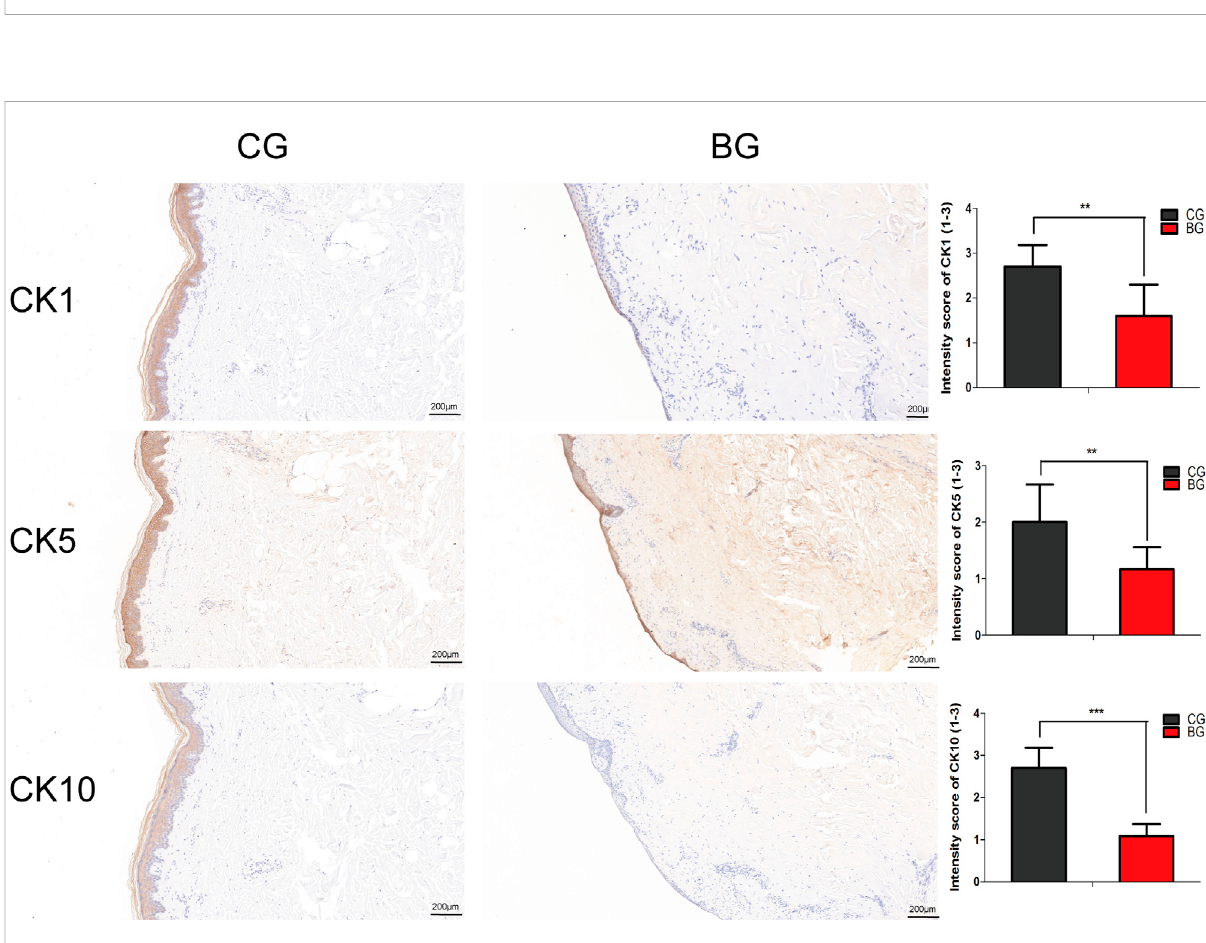
FIGURE 4 Immunohistochemical images of the two groups with antibodies against cytokeratins K1, K5, and K10. The epidermal layer was disrupted and separatedfromthedermis,whileasmallportionofthestratumbasalewasretainedintheBG.Thecytokeratinsweredistributednonhomogeneously intheresidualmiddlelayeroftheepidermis.TheintensityscoresforK1,K5,andK10inthetwogroupswerecompared,andtheexpressionsofK1,K5, andK10weresigni fi cantly decreasedintheBG.K1:cytokeratin1,K5:cytokeratin5,K10: cytokeratin10.(Bars =200 μ m,*: p < 0.05,**: p < 0.01, and ***: p <